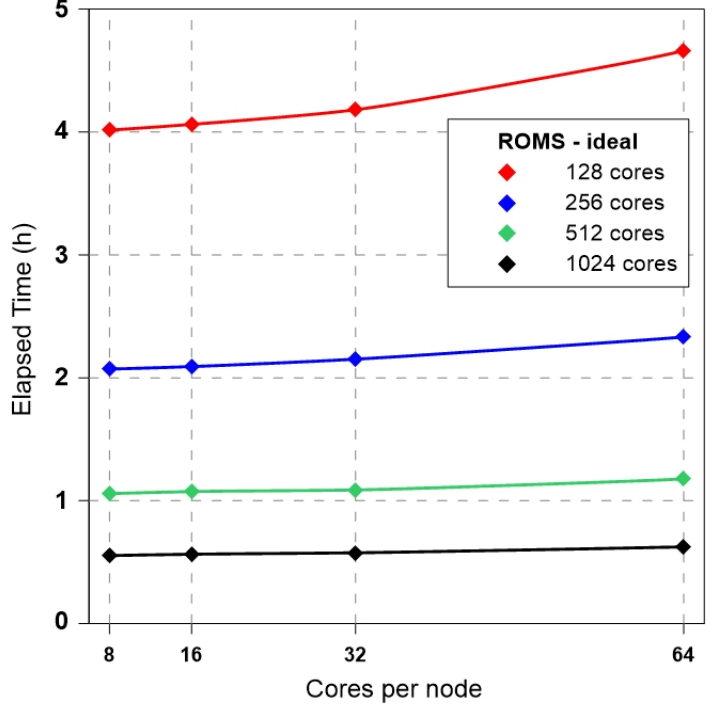
Figure 11. ROMS benchmark performances using 8, 16, 32 and 64 cores per node while reducing node usage in the KNL